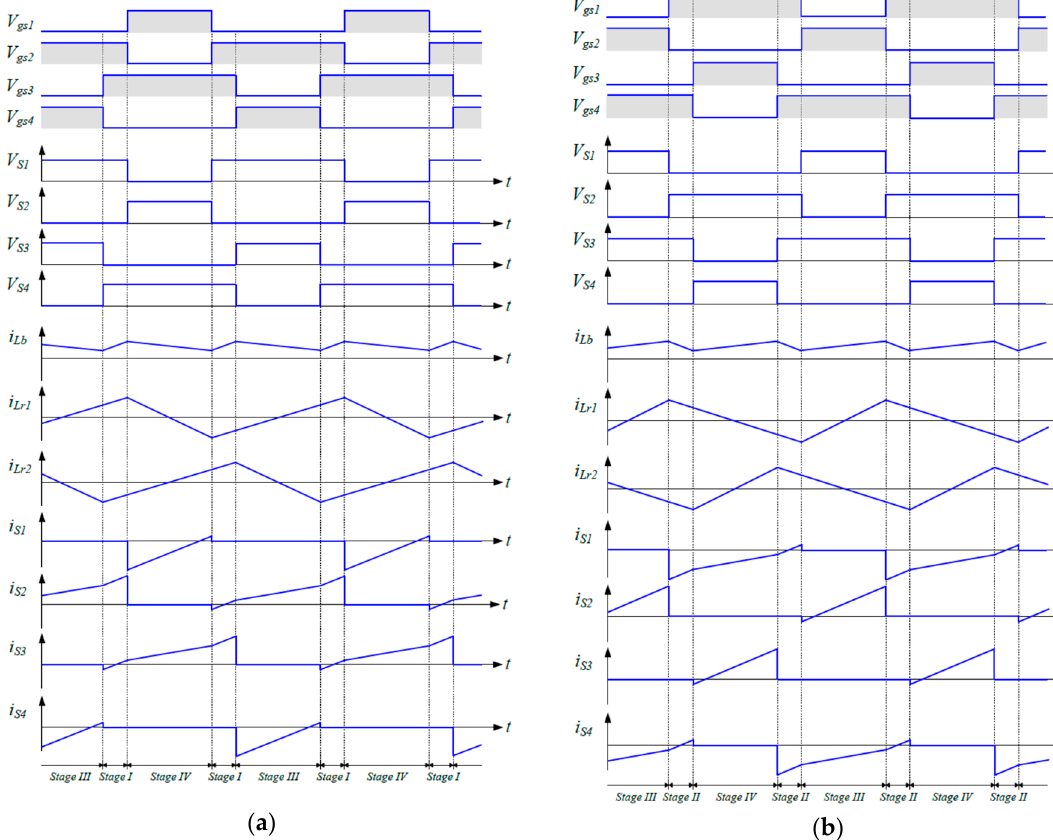
Figure 4. The operation waveforms when the converter operates in the step-up mode: ( a ) D > 0.5; ( b ) D < 0.5.